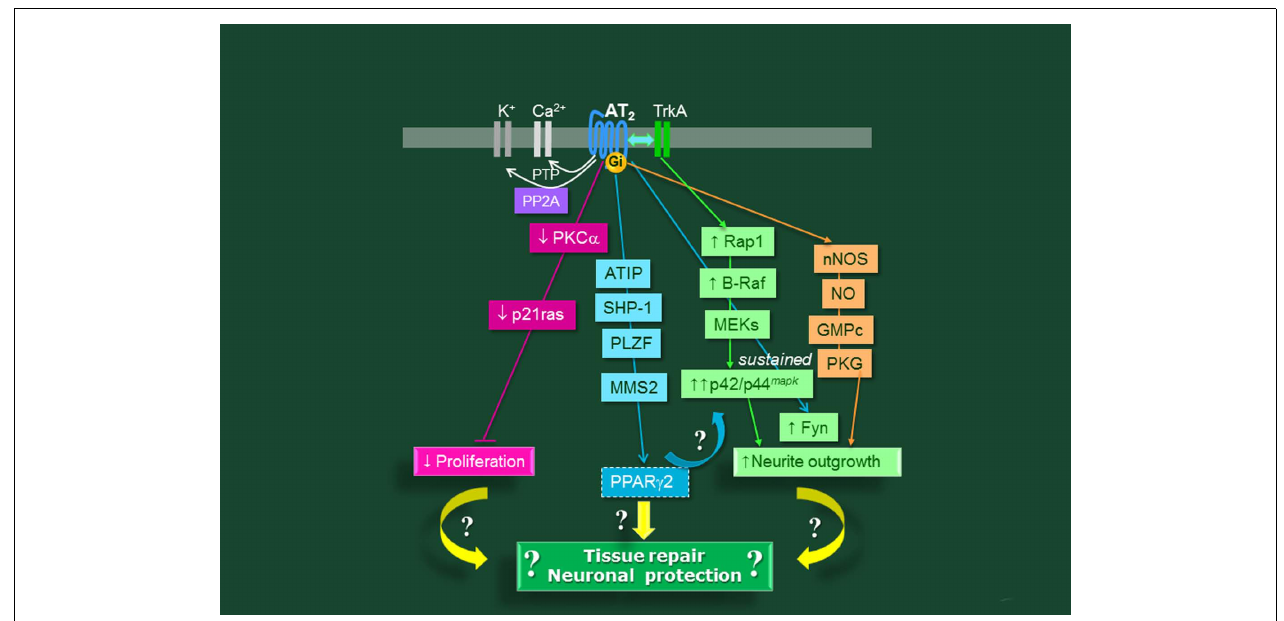
FIGURE 3 | Main signaling pathways for theAT2 receptor of angiotensin II in the